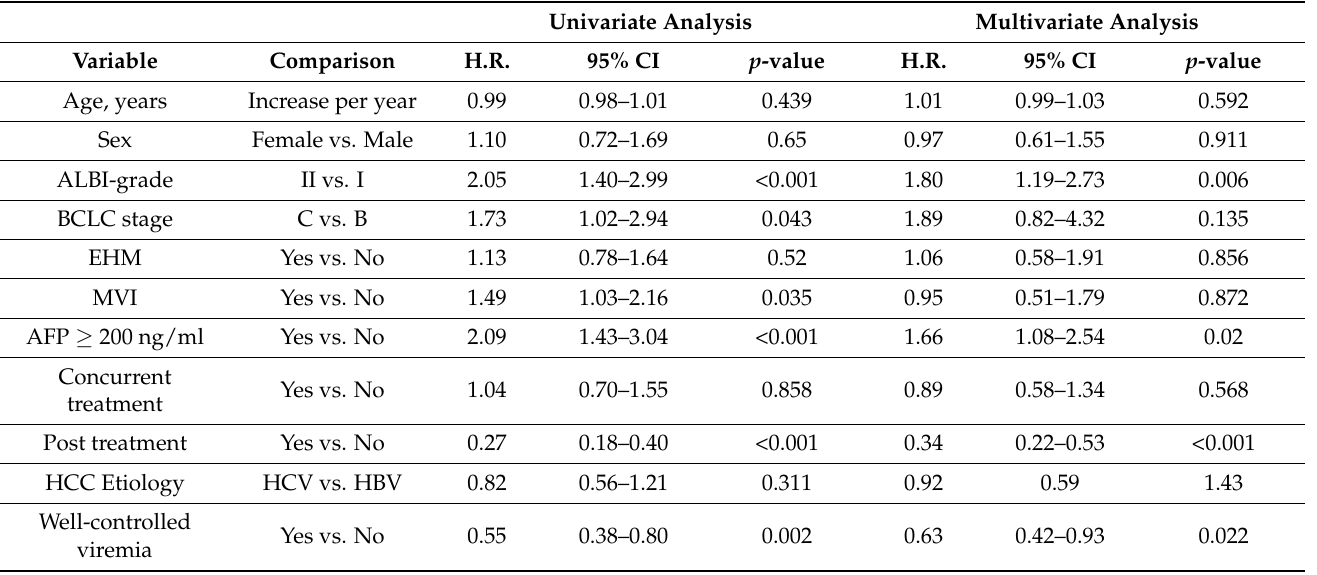
(Table 4). HBV or HCV infection, different virus etiologies of HCC, did not contribute to OS, neither for univariate nor multivariate analysis. Table 4. Factors associated with overall survival of patients with sorafenib in the univariate and multivariate